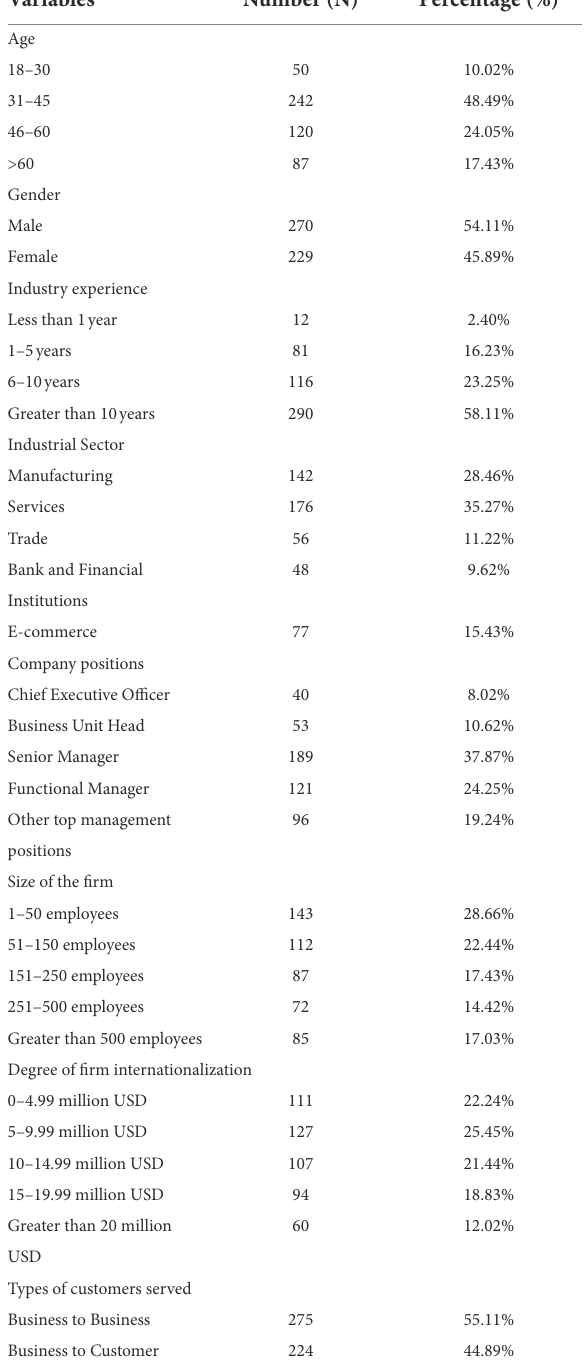
TABLE 1 Summary